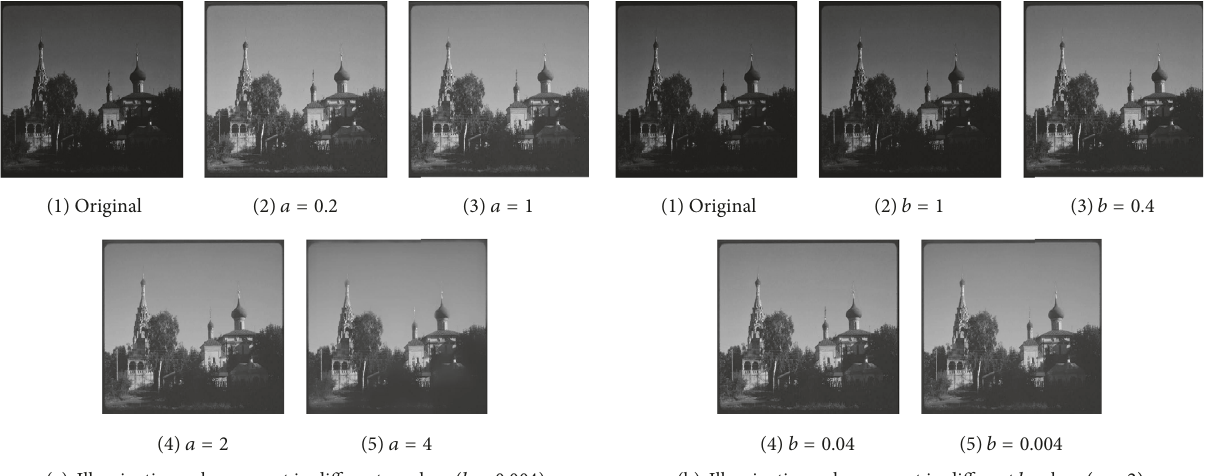
Figure 6: Illumination component enhanced by sigmoid